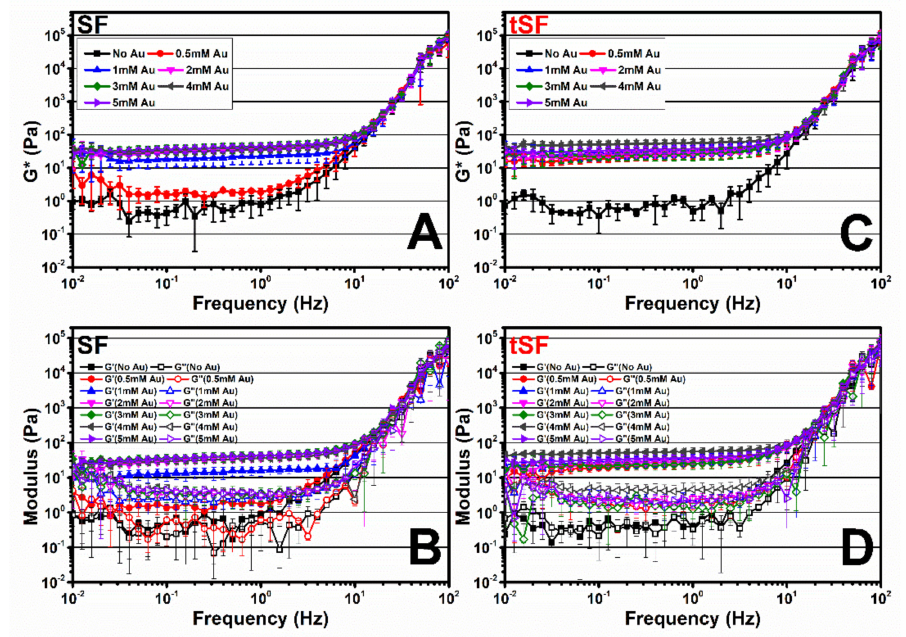
Figure 6. Frequency sweep experiments (0.01–100 Hz with 0.1% fixed strain, 37 ◦ C) of regenerated SF and the mixtures of 3% SF ( A , B ) or tSF ( C , D ) with di ff erent Au 3 + concentrations (1–5 mM). ( A , C ) Complex modulus (G*), ( B , D ) storage modulus (G’), and viscous modulus (G”) ( n =